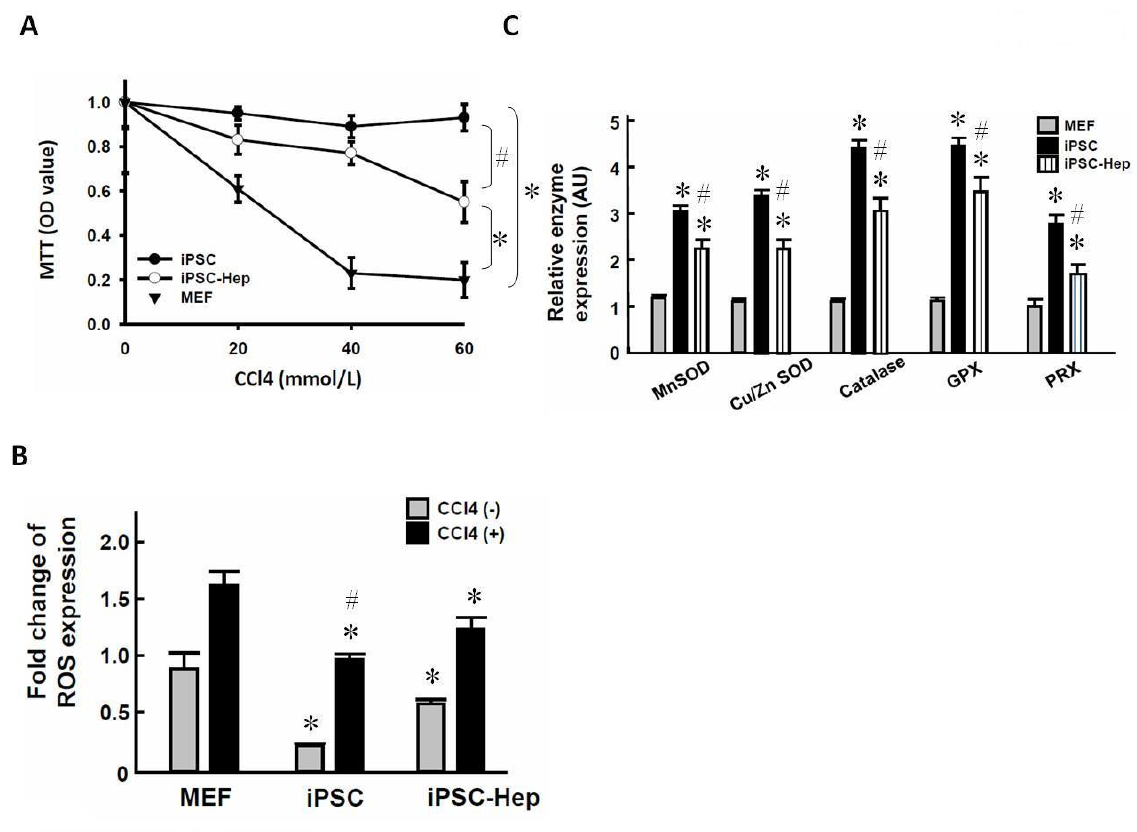
Figure 3. Effect of CCl administration on reactive oxygen species (ROS) production and 4 cell survival in vitro . ( A ) Evaluation of CCl -induced cytotoxicity and ( B ) ROS elevation 4 in MEFs, 3-genes iPSCs, and 3-genes iPSC-Heps; ( C ) Comparison of the gene expression of the antioxidant enzymes in MEFs, 3-genes iPSCs, and 3-genes iPSC-Heps using quantitative RT-PCR. Data shown here are the mean  ± SD of three independent experiments. In panels A and C, * P < 0.05 vs . MEFs. # P < 0.05 vs . iPSC-Heps. In panel B, * P < 0.05 vs . MEFs with corresponding treatment. # P < 0.05 vs . iPSC-Heps with corresponding